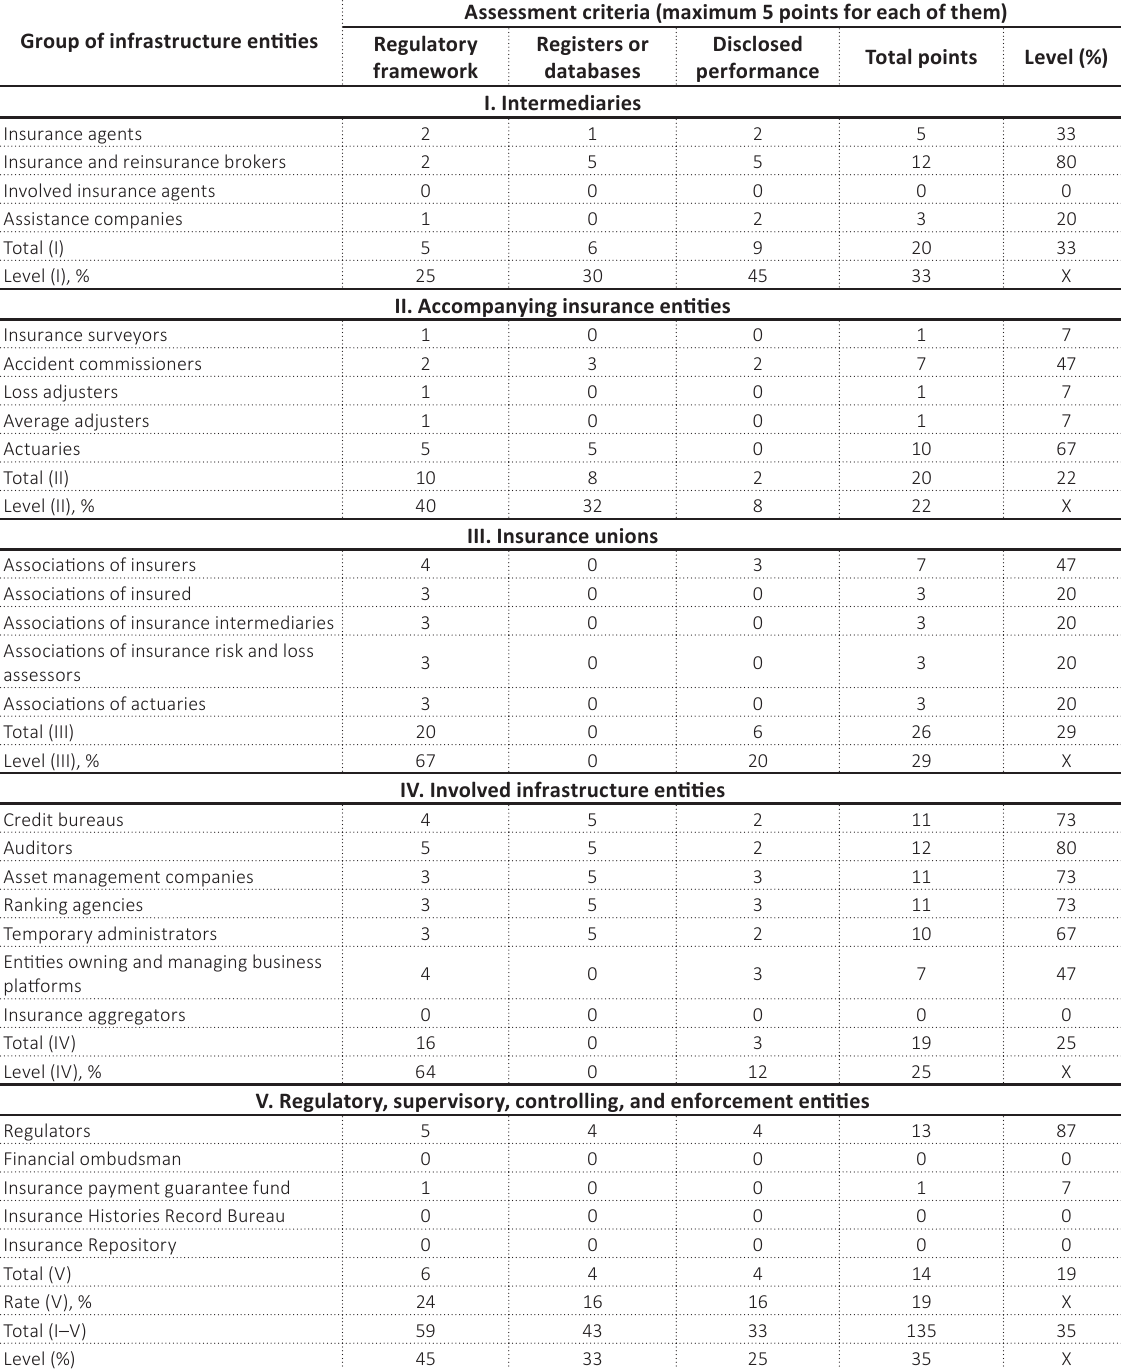
Table 3. Efficiency of insurance market infrastructure entities in Ukraine, 2019 Source: Calculated by the authors based on data of the regulators. Assessment criteria (maximum 5 points for each of